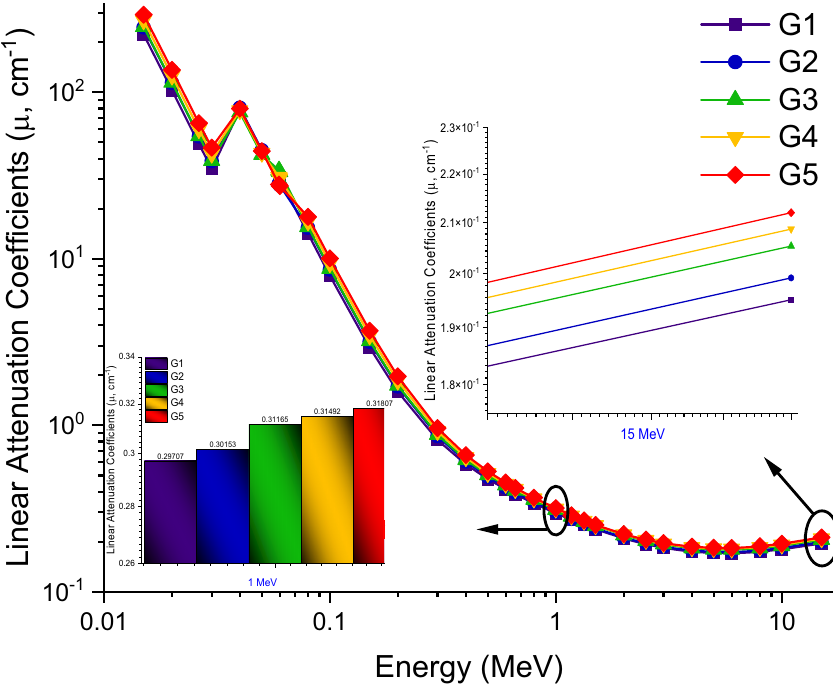
Figure 3: Variation of linear attenuation coe ffi cient ( cm − 1 ) with photon energy ( MeV ) for all G1 – G5 glasses.